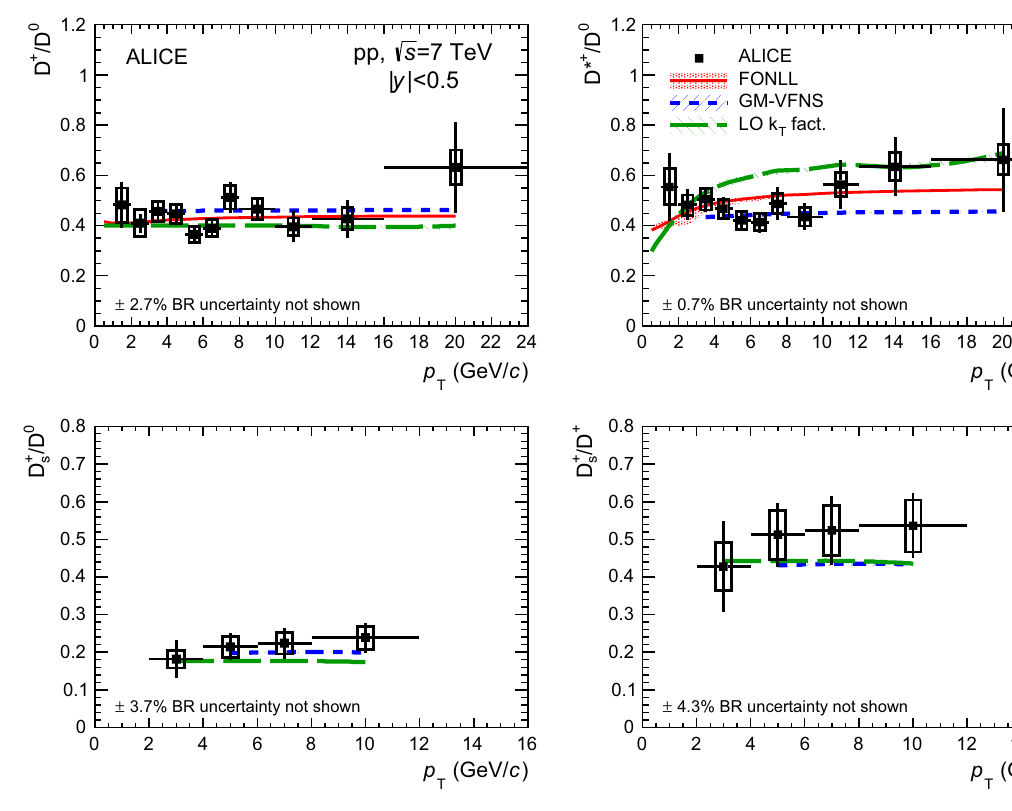
Fig. 8 Ratios of D-meson production cross sections as a function of p T . Predictions from FONLL, GM-VFNS and LO k T -factorisation cal- culations are also shown. For the pQCD calculations the line shows the